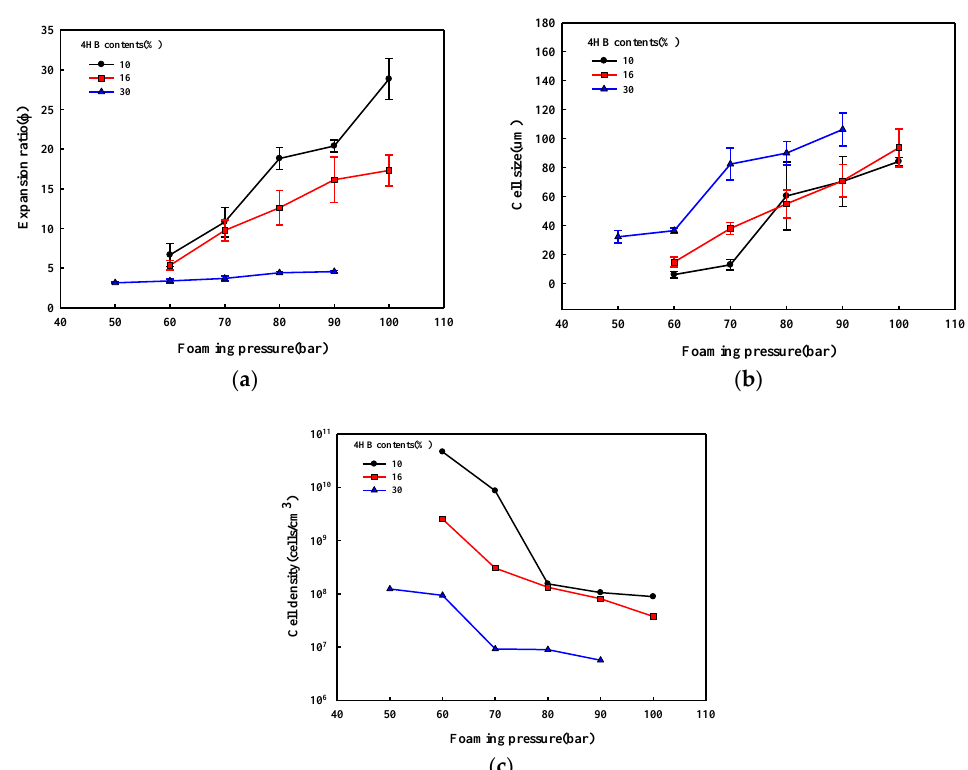
Figure 7. SEM micrographs of P(3HB- co -4HB) foamed at various foaming pressure. Foaming temperatures of P(3HB- co -10% 4HB), P(3HB- co -16% 4HB), and P(3HB- co -30% 4HB) are 130 °C, 100 °C, 50 °C, respectively.